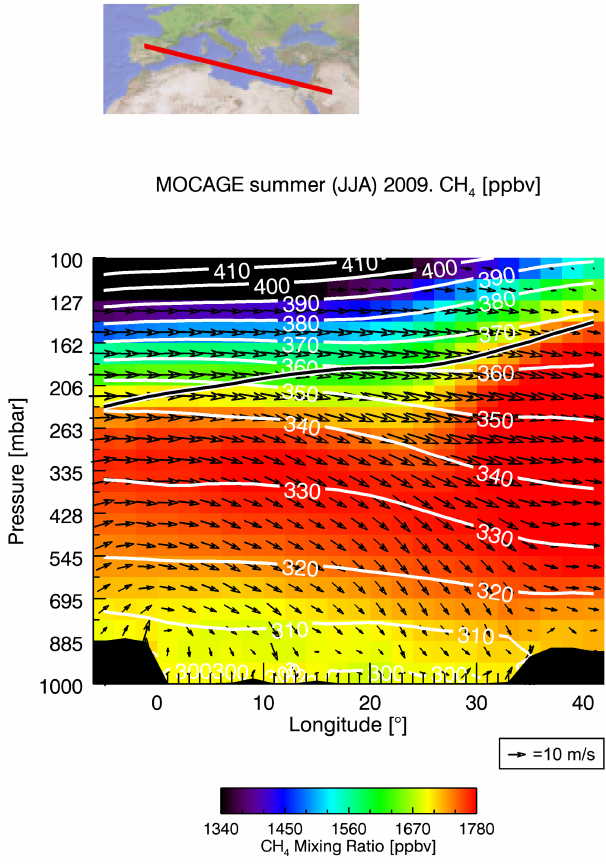
Figure 2. Vertical distribution of CH 4 as calculated by MOCAGE and averaged for JJA 2009 as a function of longitude along the red line represented above the figure. Superimposed are the as- sociated longitudinal and vertical winds from ARPEGE, together with the isentropes (white lines) and the cold point tropopause from NCEP/NCAR reanalyses (black line) averaged over the same pe- riod.